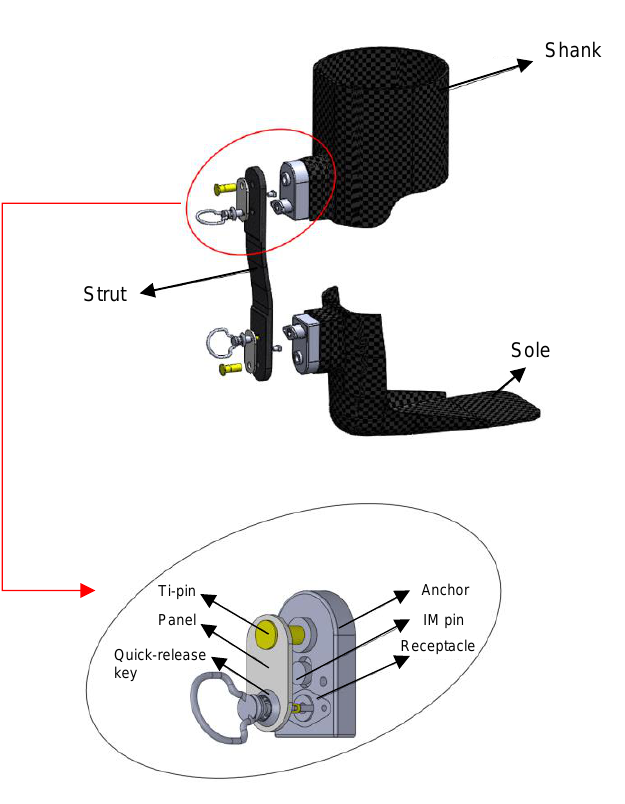
Figure 1: Quick release AFO with quick release